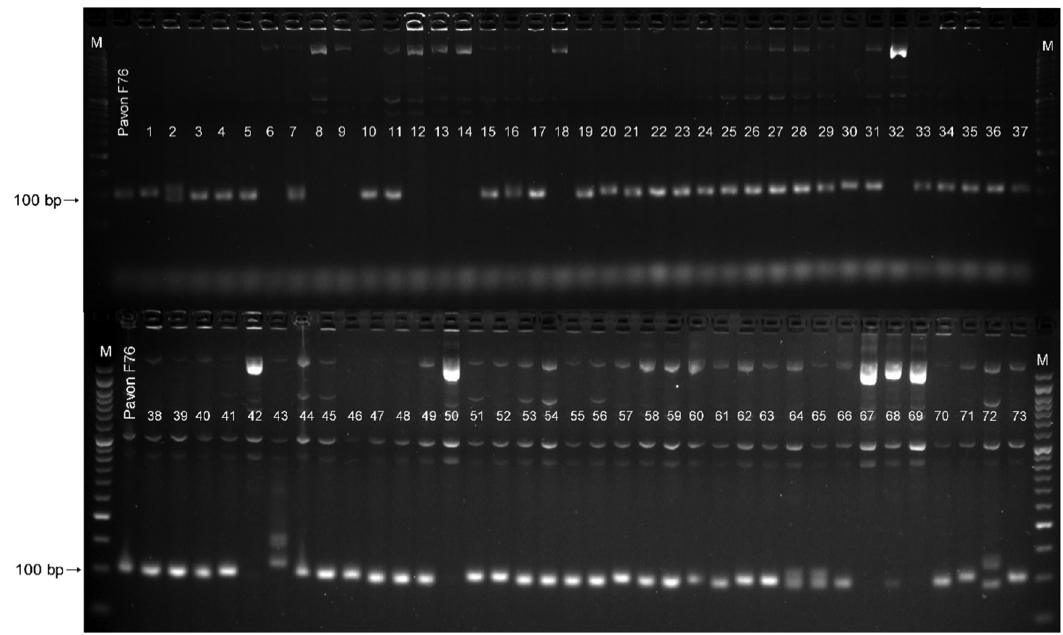
Figure 2: Ampli fi cation products of PCR of wheat genotypes with Xgwm259 marker linked to Lr46 locus. M, FastGene 50 bp DNA Ladder ( NIPPON Genetics EUROPE GmbH ) ; 1 – 73 – wheat genotypes.